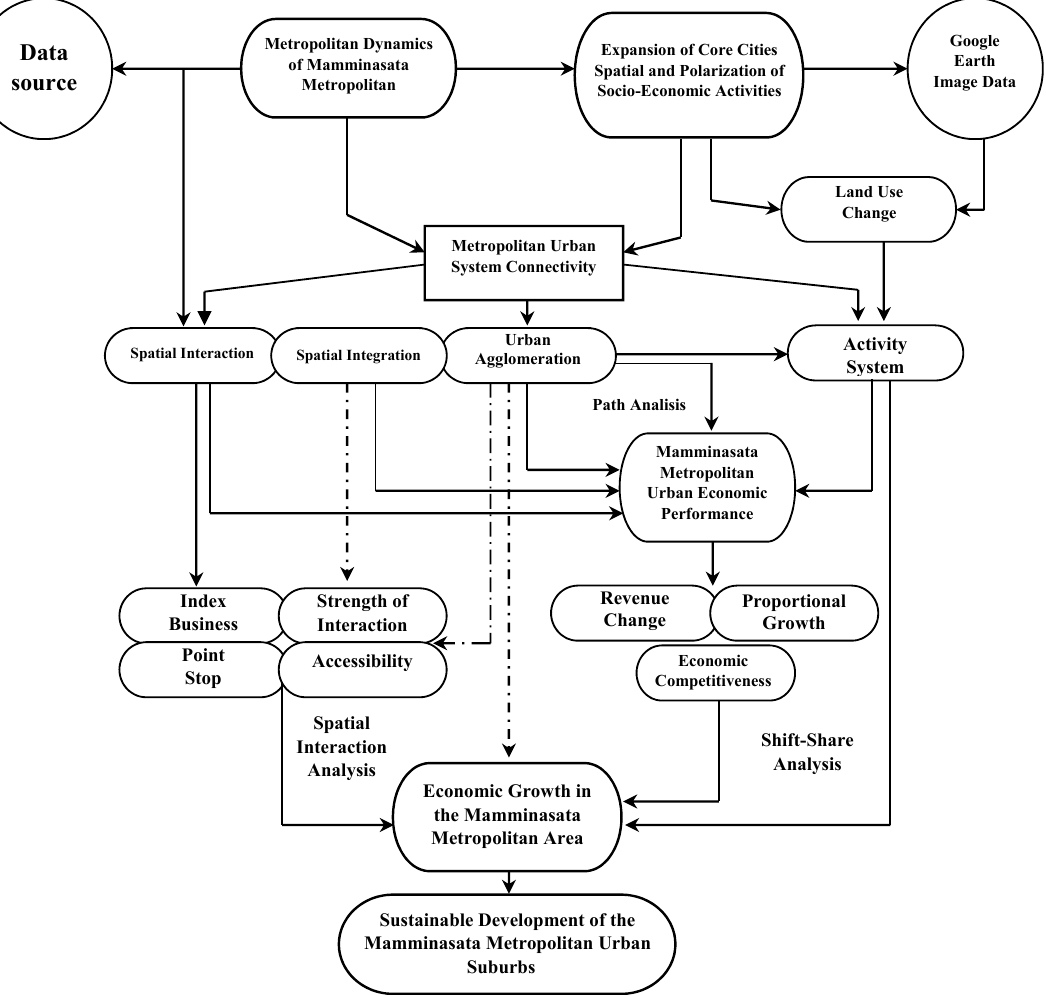
Figure 4. Relationship Between Spatial Integration, Spatial Interaction, Urban Agglomeration, and Activity System of the Suburbs of the Mamminasata Metropolitan Area. Source: author elaboration.